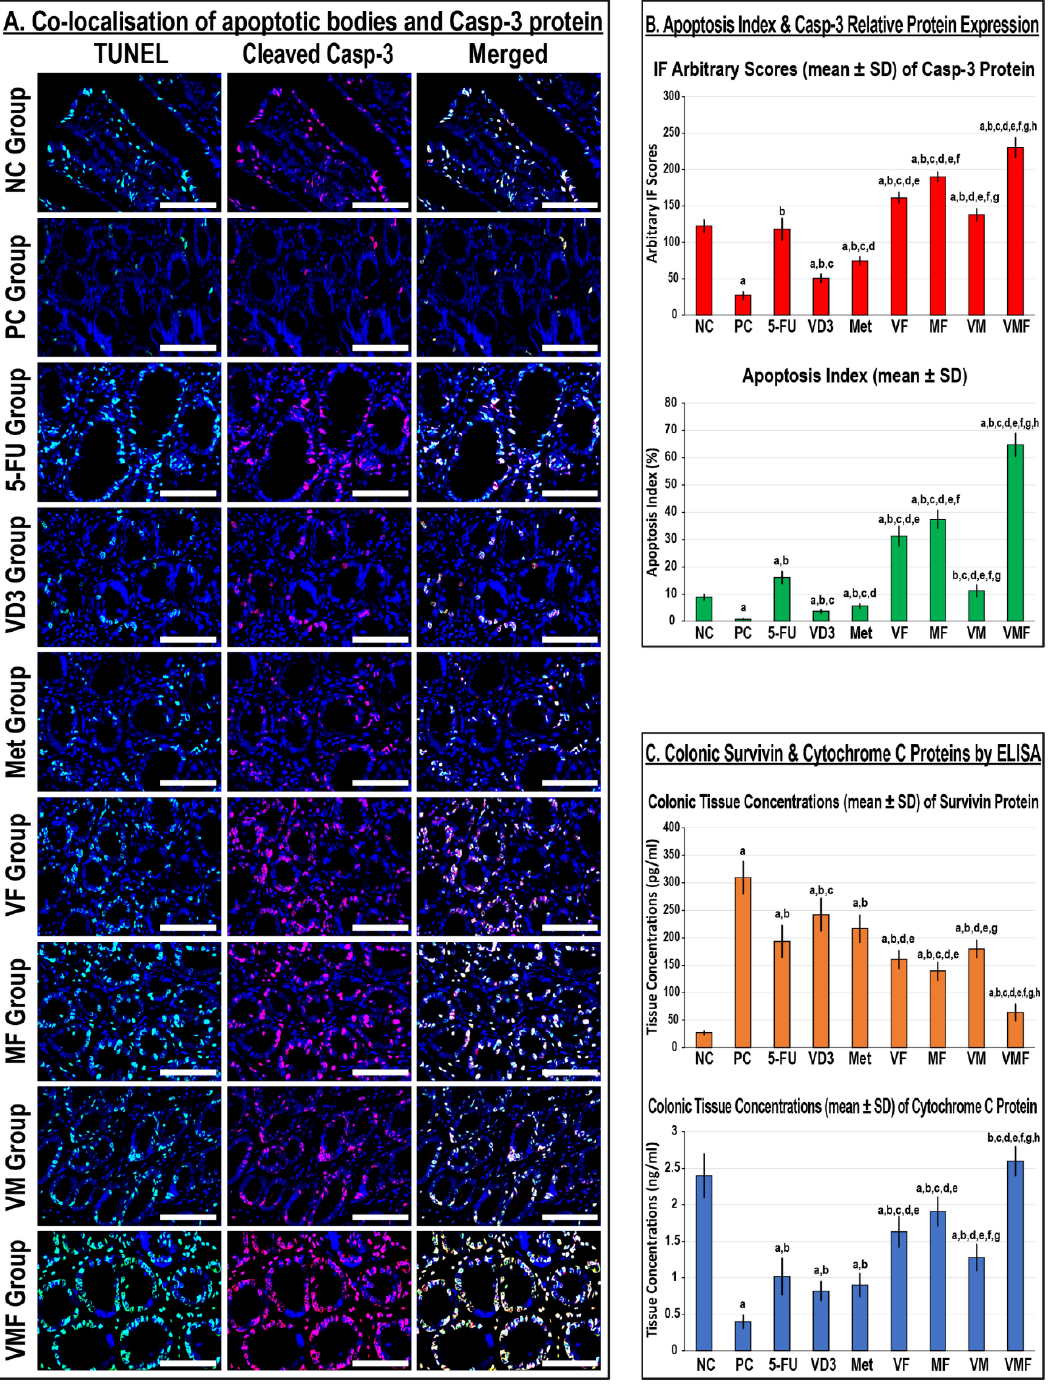
Figure 5. ( A ) Co-detection of apoptotic bodies by TUNEL (green) with cleaved Casp-3 (red) by immunofluorescence in the colonic tissues from all the study groups (n = 10 mice/group; 40× objective; scale bar = 8 µm). ( B ) The relative expression of the Casp-3 protein alongside the apoptosis index and ( C ) the colonic tissue concentrations of survivin and cytochrome C proteins from all groups are displayed as bar graphs (n = 10 mice/group; data were analysed by ANOVA followed by Tukey’s HSD test and are shown as the mean ± SD; a = p < 0.05 compared with the NC group; b = p < 0.05 compared with the PC group; c = p < 0.05 compared with 5-FU monotherapy; d = p < 0.05 compared VD 3 monotherapy; e = p < 0.05 compared with Met monotherapy; f = p < 0.05 compared with VF dual therapy; g = p < 0.05 compared with MF dual therapy; and h = p < 0.05 compared with VM dual therapy).